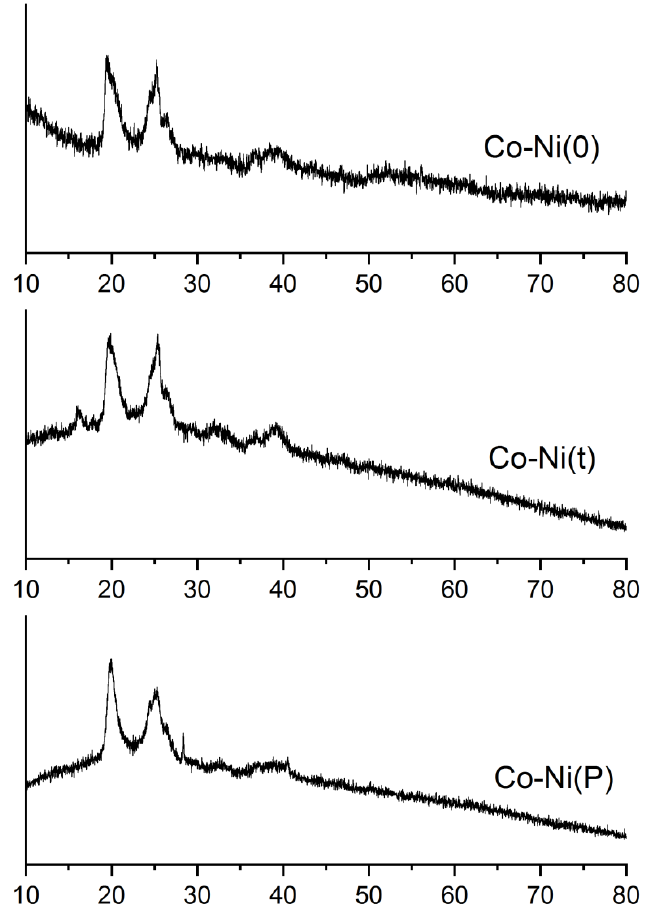
Figure 4. XRD patterns of the Co-Ni complexes used in this work.